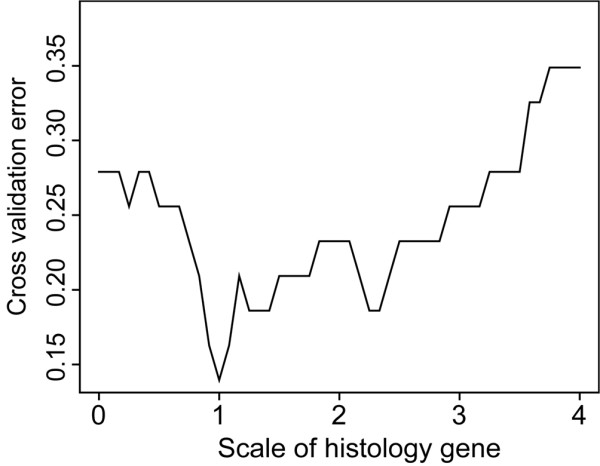
Variation in error rate according to scale of 'histology gene'. An 11th ('histology') gene was added to a 10-gene predictor as an extra dimension. This gene was rescaled from 0 to 4 standard deviations, and the effect on cross-validation error calculated.